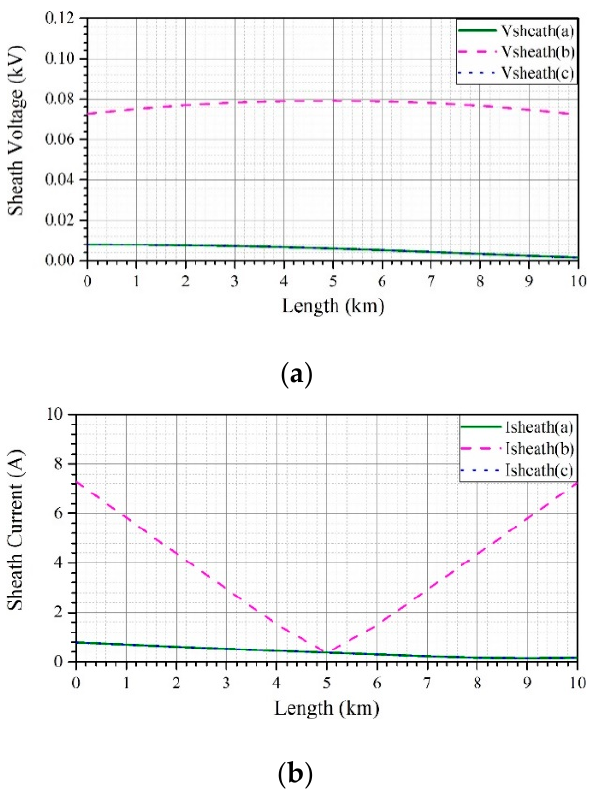
Figure 10. Sheath voltage and currents in steady state ( a ) Steady state sheath voltage along the length of cable. ( b ) Steady state sheath circulating currents along the length of the cable. Table 2. DC and Dominant Voltage Harmonic Components at the Sending End of a 10 km Cable using CBM.